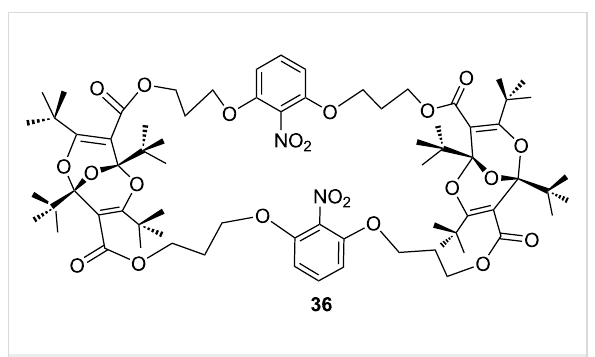
Figure 2: Cyclic bisdioxine derivative not forming a tetraoxaadaman- tane due to reduced cavity size.